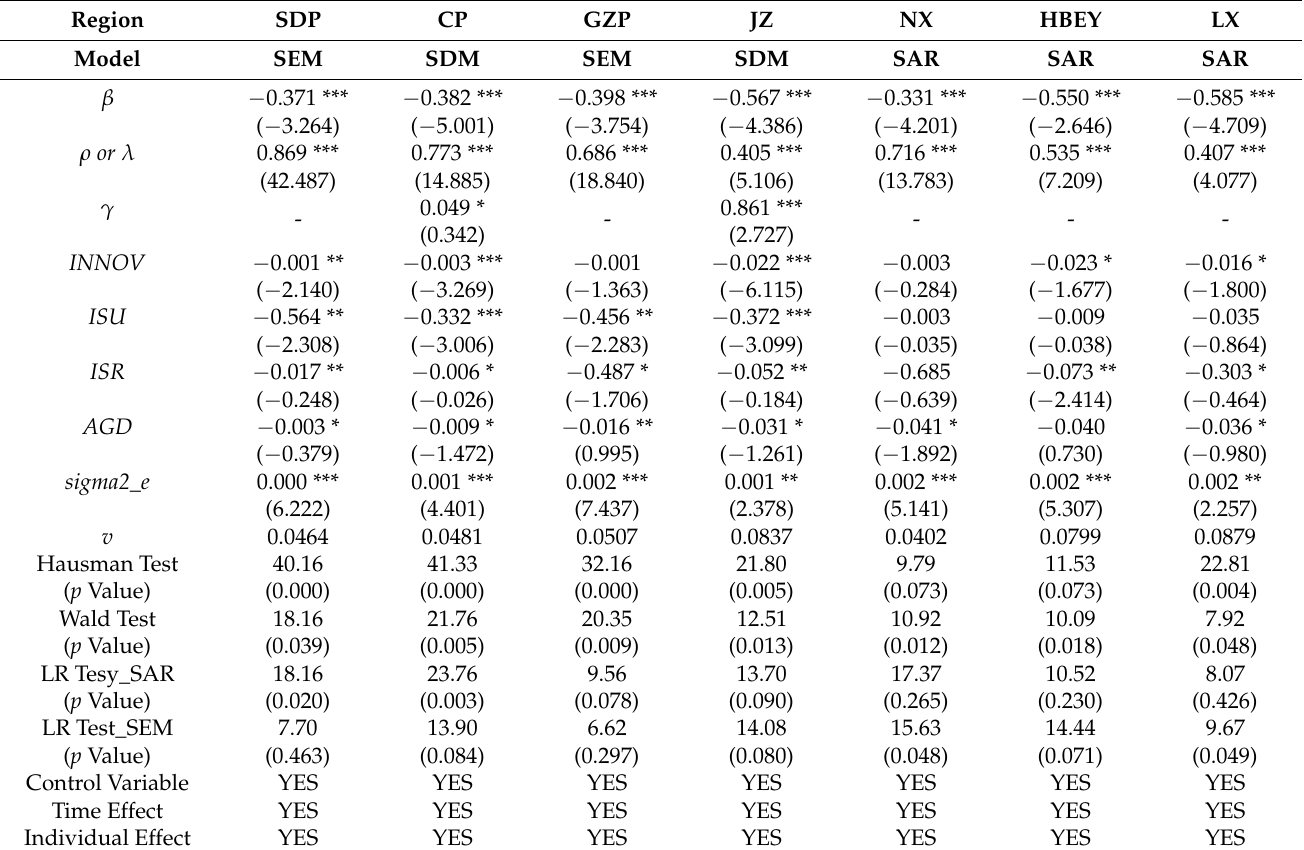
Table 7. Conditional β convergence characteristics of CEI of urban agglomerations in the